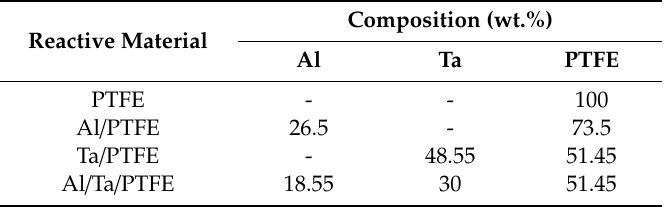
Table 1. Component ratios of four groups of reactive materials.